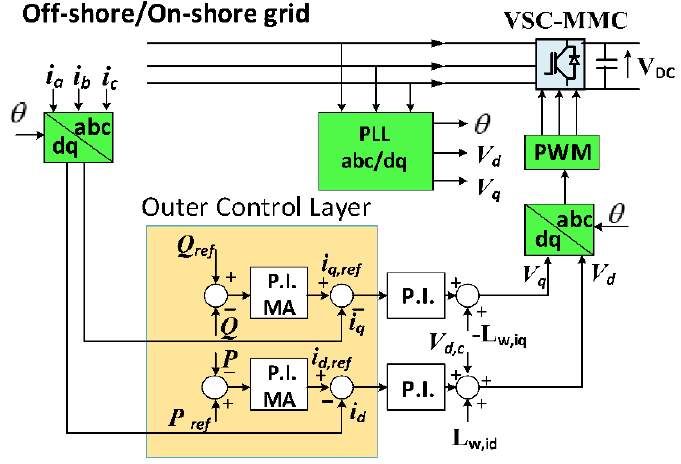
Figure 11. The control structure of OCL using MA .